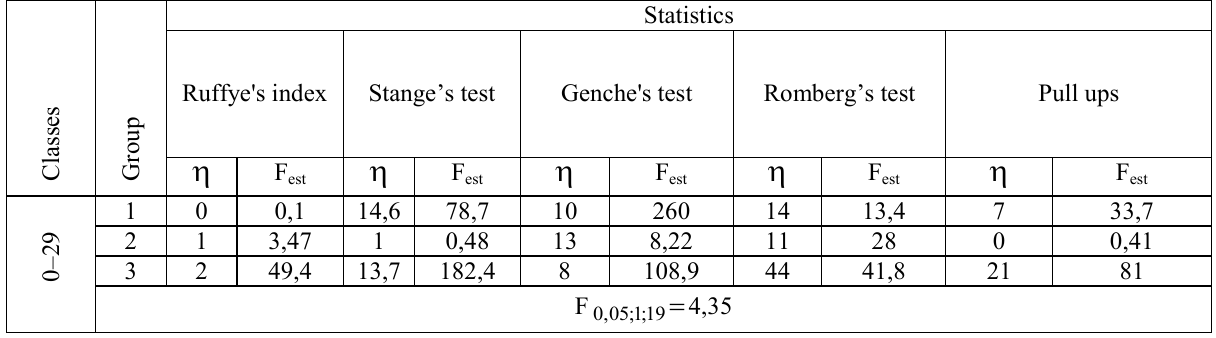
The extent of influence of specializations on results of the functional and moving tests (%) of male students of the fourth